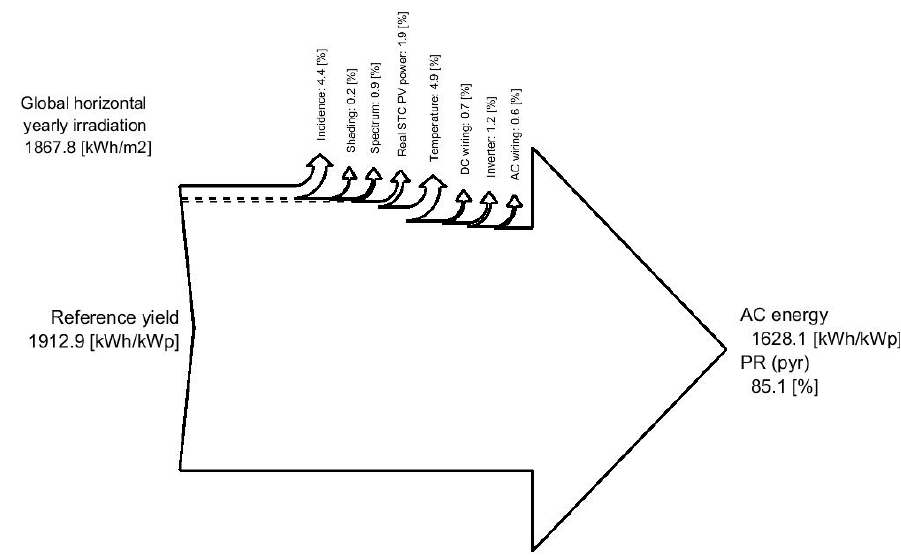
Figure 3. Annual AC energy output as predicted by PV simulator SISIFO [23] for the southwest- oriented APV system in Brenes, Seville, Spain. Table 8. Annual PV income for 24 ha and due SW orientation, assuming a 5% loss as to PV productive land, due to plot dead corners (PV productive land of 22.8 ha). PV Module Year Degrad.